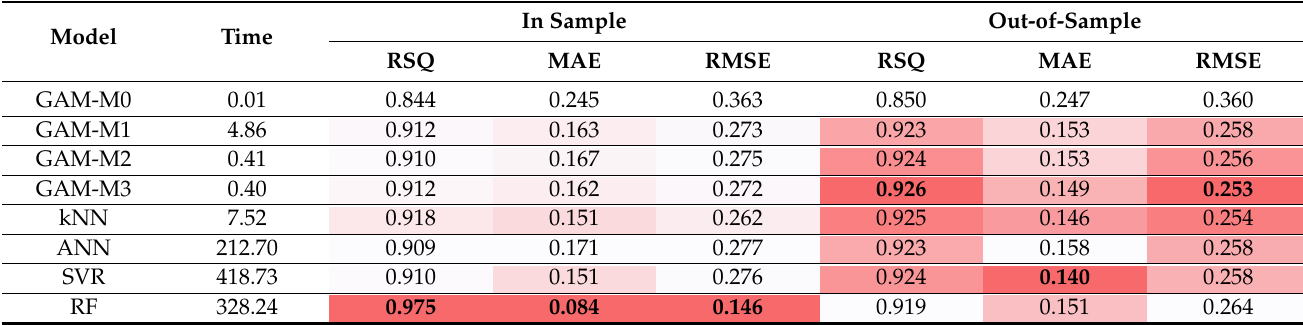
Table 2. Forecasting accuracy and computation time of each method for individual PV power generation.